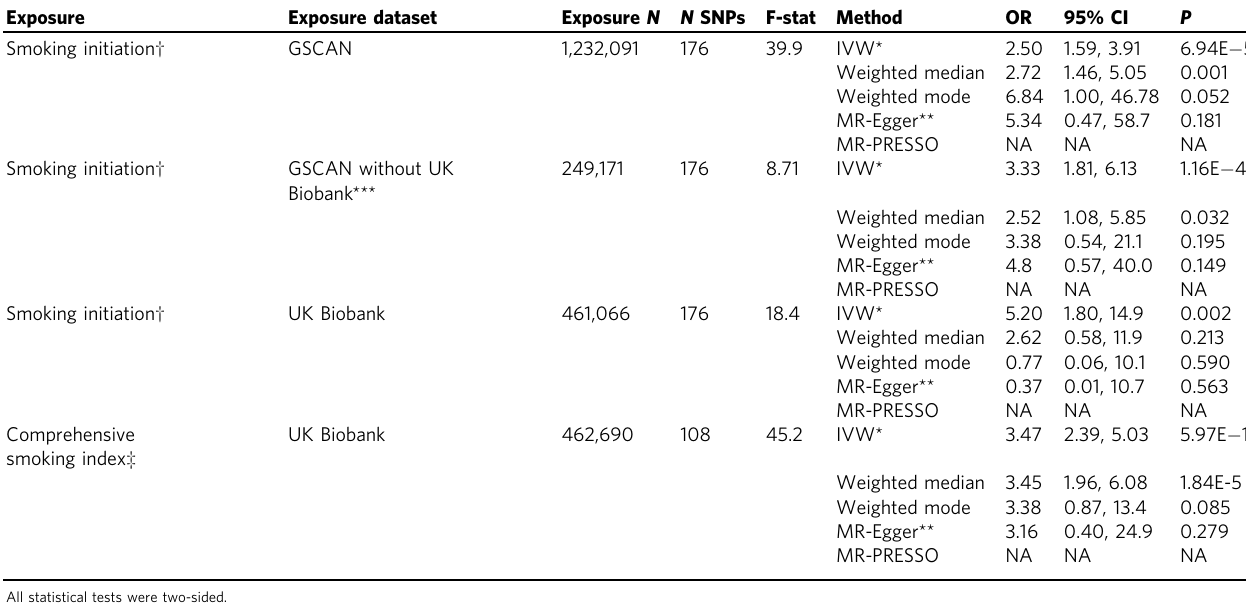
Table 1 Univariable Mendelian randomisation of smoking and risk of oral and oropharyngeal cancer. Exposure